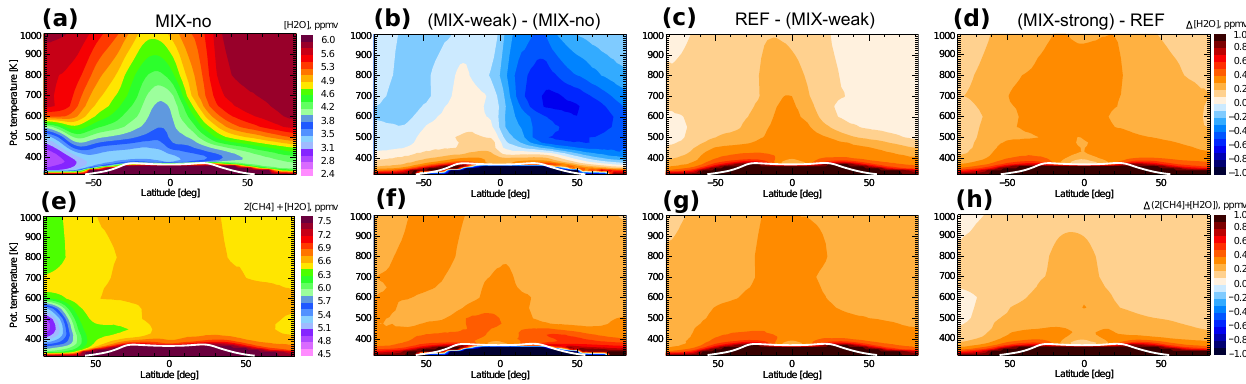
Figure 13. Annual zonal mean distributions of water vapour (a) and total water (e) from the CLaMS simulation without mixing (MIX-no), as well as the incremental differences between the sensitivity simulations with increasing mixing from the weak mixing case (MIX-weak) through the reference (REF) to the strong mixing case (MIX-strong), i.e. ((MIX-weak) – MIX-no) in the second column (b, f) , (REF – (MIX-weak)) in the third column (c, g) , and ((MIX-strong) – REF) in the fourth column (d, h) . Tropopause is represented by a white solid line and is calculated from ERA-Interim reanalysis data. The data are shown for 2011.